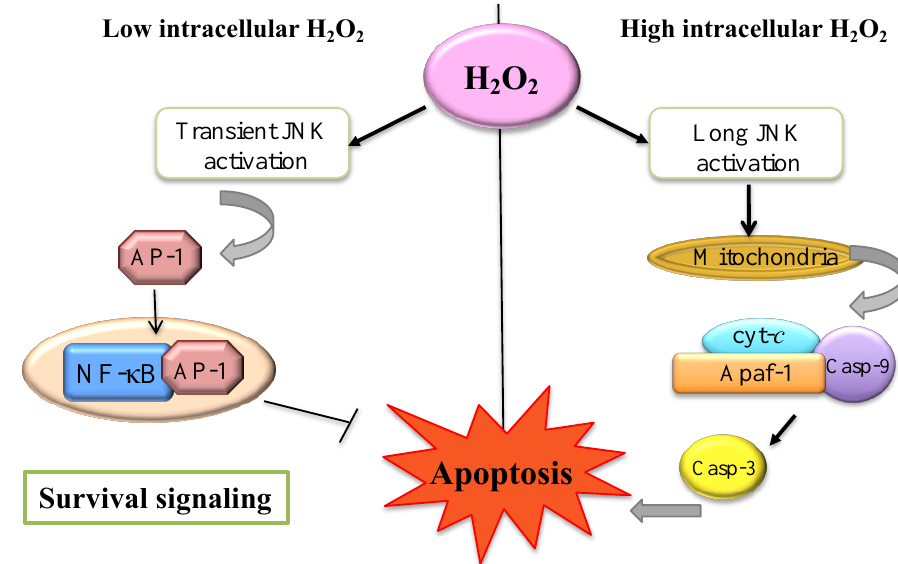
Figure 2. Survival and apoptotic signaling. High intracellular H 2 O 2 induces long c-Jun NH2-terminal kinase (JNK) activation and lead to mitochondrial cyt- c complex release dependent cell death. Low intracellular H 2 O 2 levels allow AP-1 transcription factor and anti-apoptotic genes activation [40].